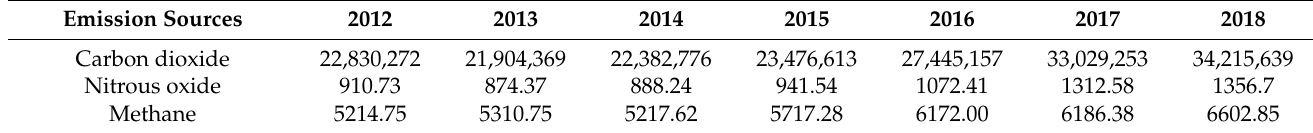
Table 3. Air emissions accounts in tonnes in Poland in 2012–2018 in transport and storage [57]. Emission